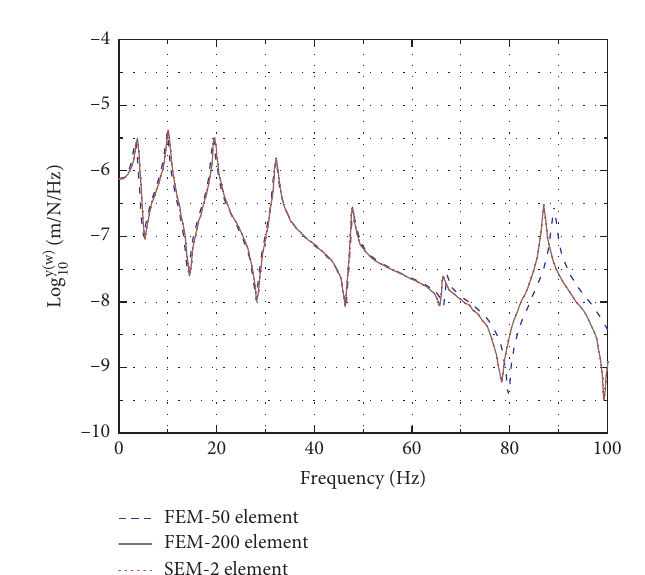
Figure 5: Frequency response function